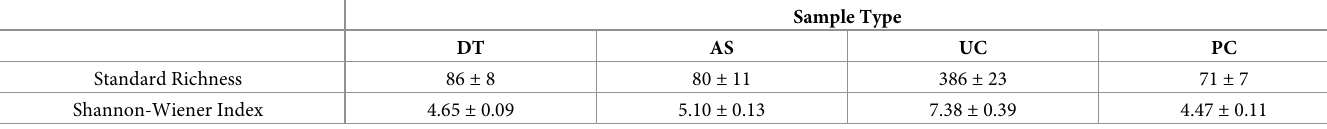
Table 2. Average alpha diversity within sample types. Standard richness and Shannon-Wiener Index values are provided with standard error. Acronyms are as follows: DT–Adult digestive tracts, AS–Anal secretions, UC–Unprepared carcasses, PC–Prepared carcasses.